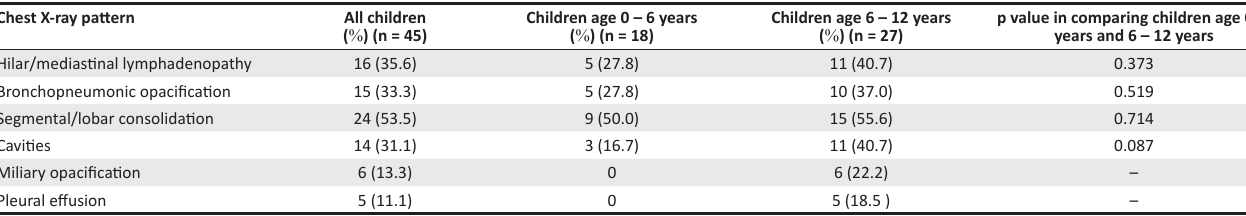
TABLE 1: Chest X-ray patterns in all children and comparison by age. Chest X-ray pattern